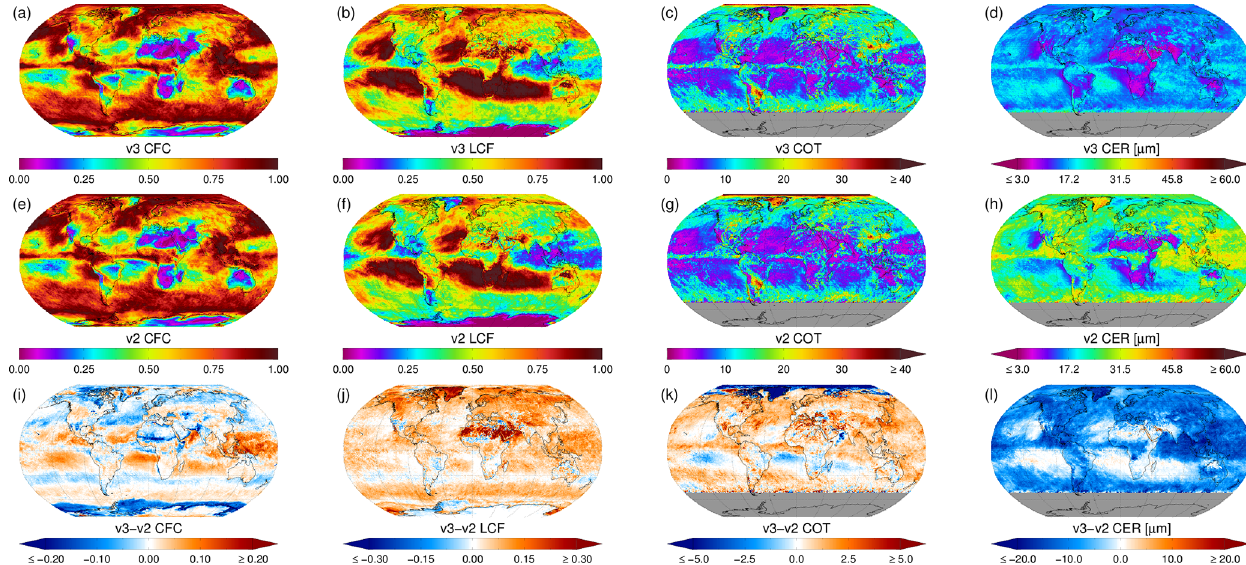
Figure 1. Examples of Level-3C (monthly means) Cloud_cci AVHRR-PMv3 data for cloud fraction (CFC) (a) , liquid cloud fraction (LCF) (b) , cloud optical thickness (COT) (c) and cloud effective radius (CER) (d) . Same data are shown for v2 (e) – (h) . Difference maps are shown in panels (i) – (l) . All data are from June 2014.